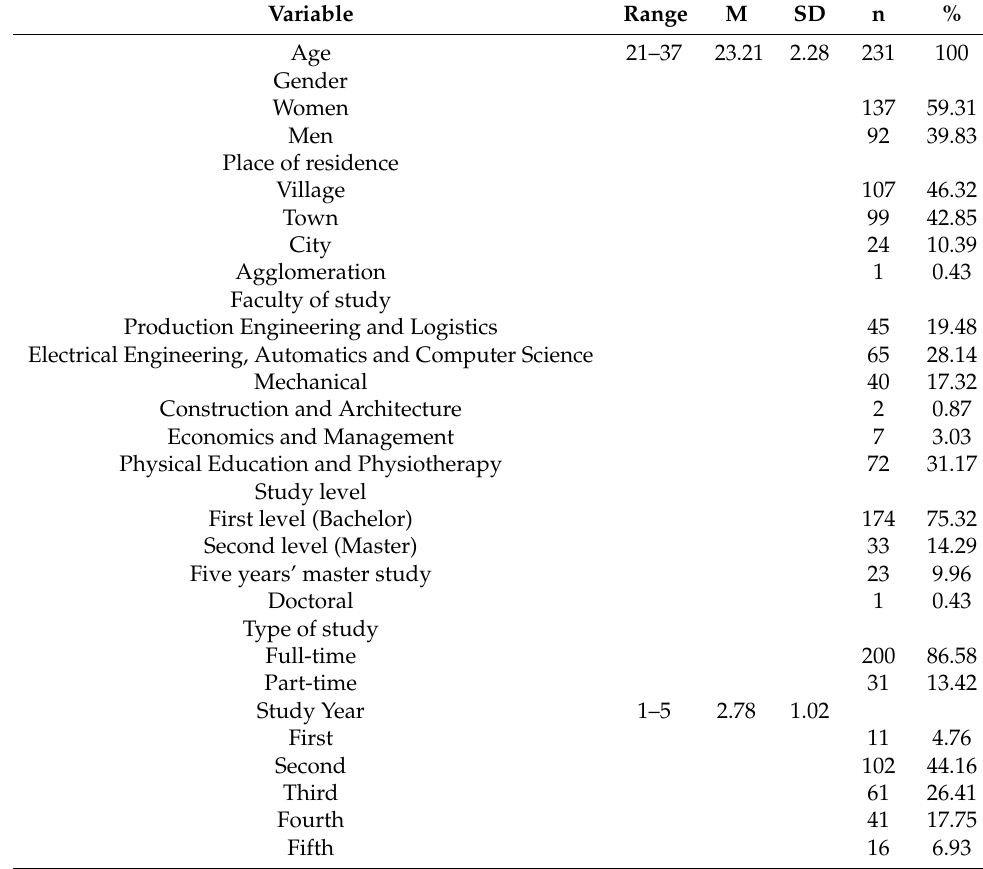
Table 1. Demographic characteristics of the sample during the second wave of the COVID-19 pandemic.